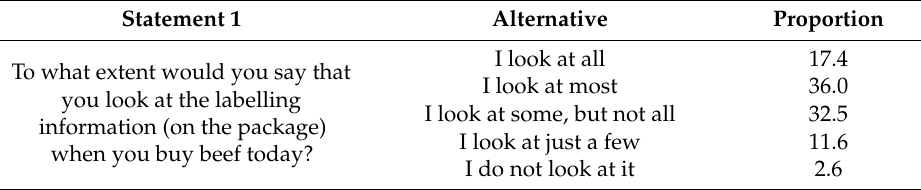
Table 2. Respondents’ stated use of labelling information when buying beef as a